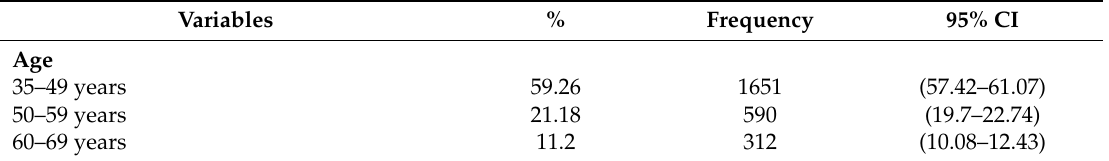
Table 2. Demographic and socioeconomic characteristics of Saudi women 35 + years